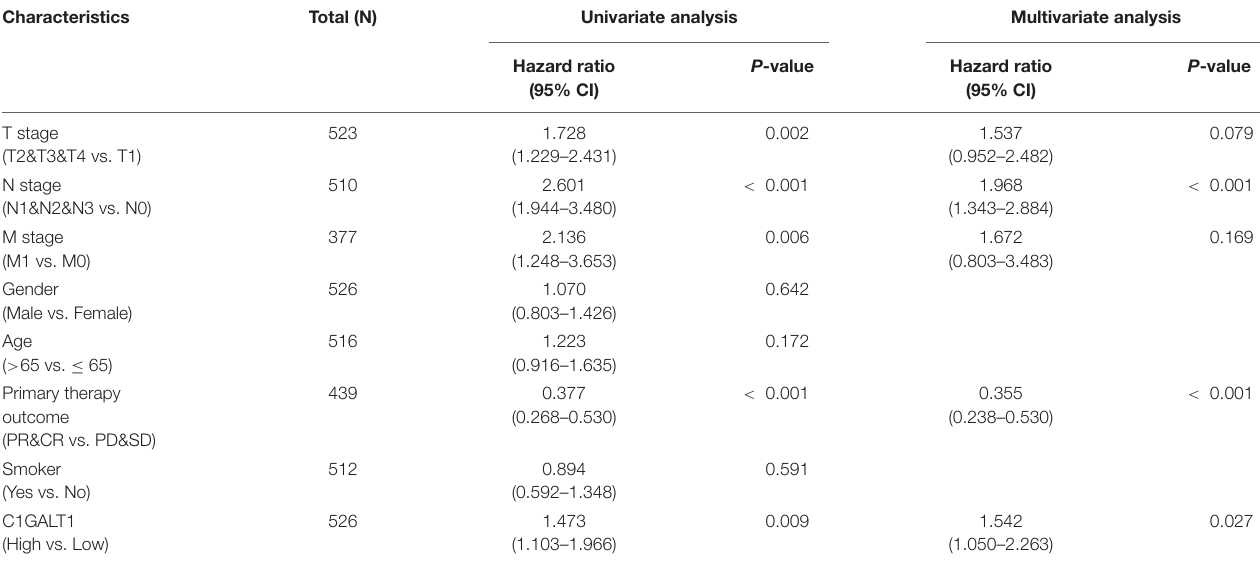
TABLE 1 | Univariate and multivariate Cox proportional analysis for overall survival.